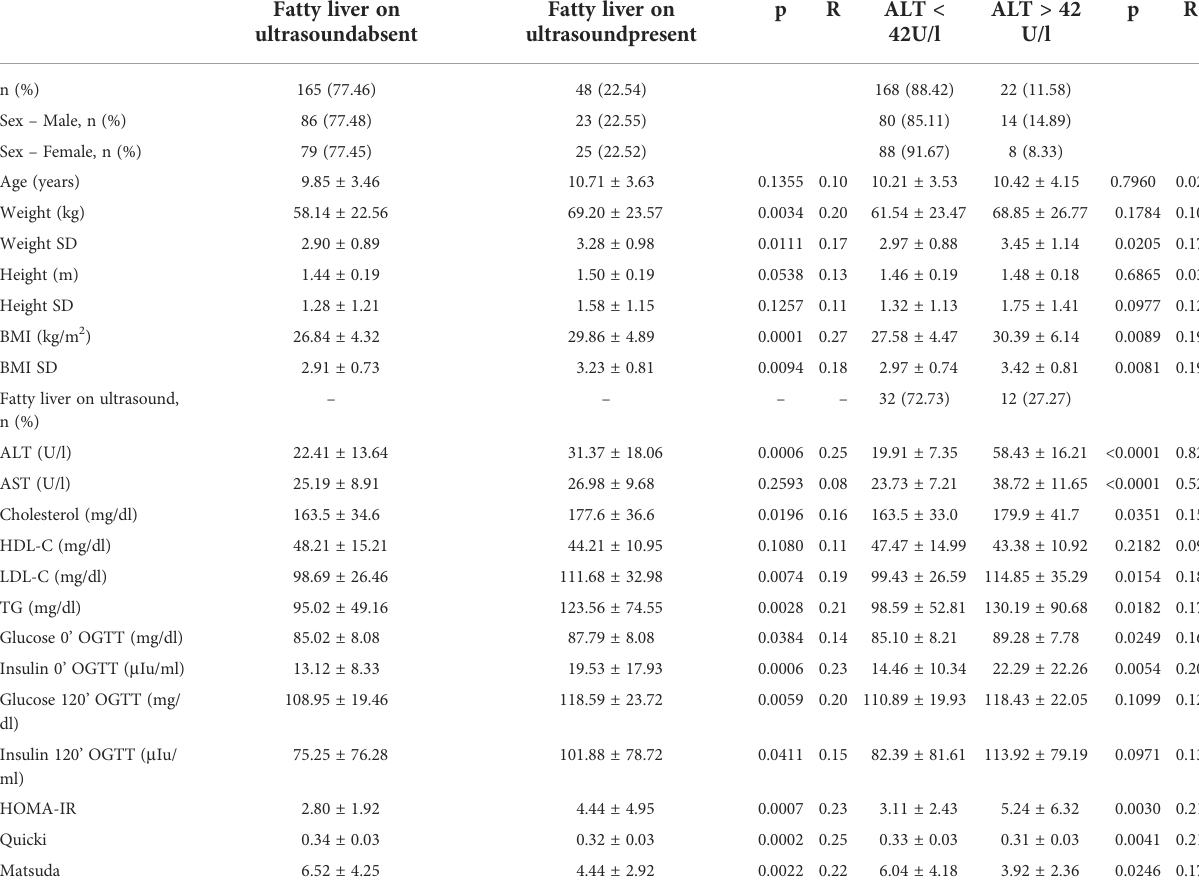
TABLE 2 Subjects characteristic by presence of fatty liver on ultrasound and alanine aminotransferase levels. Fatty liver